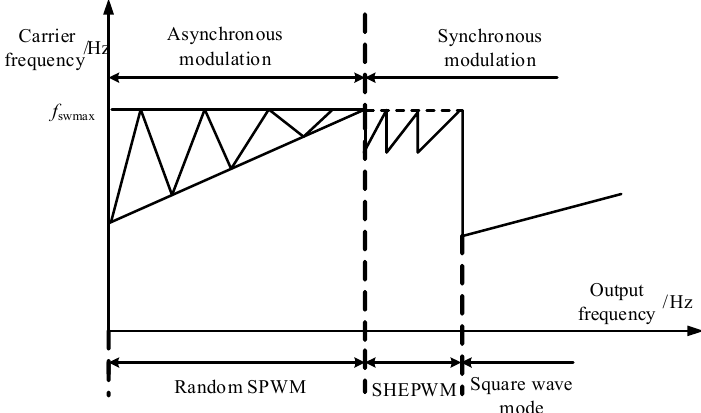
Figure 1. The modulation scheme for a traditional 2 L traction converter. To further increase the voltage and power level, multilevel converters like cascaded half-bridge (CHB) [5,6] and modular multilevel converter (MMC) [7,8] are proposed and